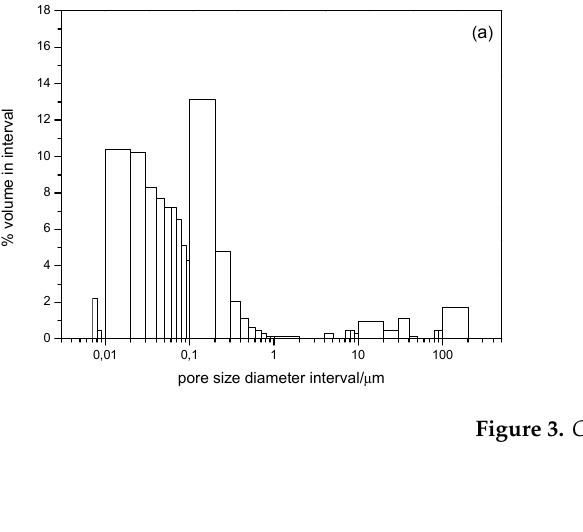
Figure 3. Porosity distribution of the samples: G (a), W (b), G-5 (c), W-5 (d), G-10 (e) and W-10 (f). 293 294